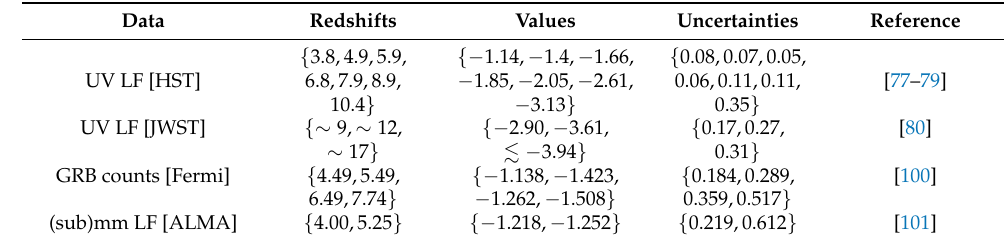
Table 2. Overview of the estimate for the cosmic SFR density considered in the Bayesian analysis of this work. Values and uncertainties refer to log SFR [ M (cid:12) yr − 1